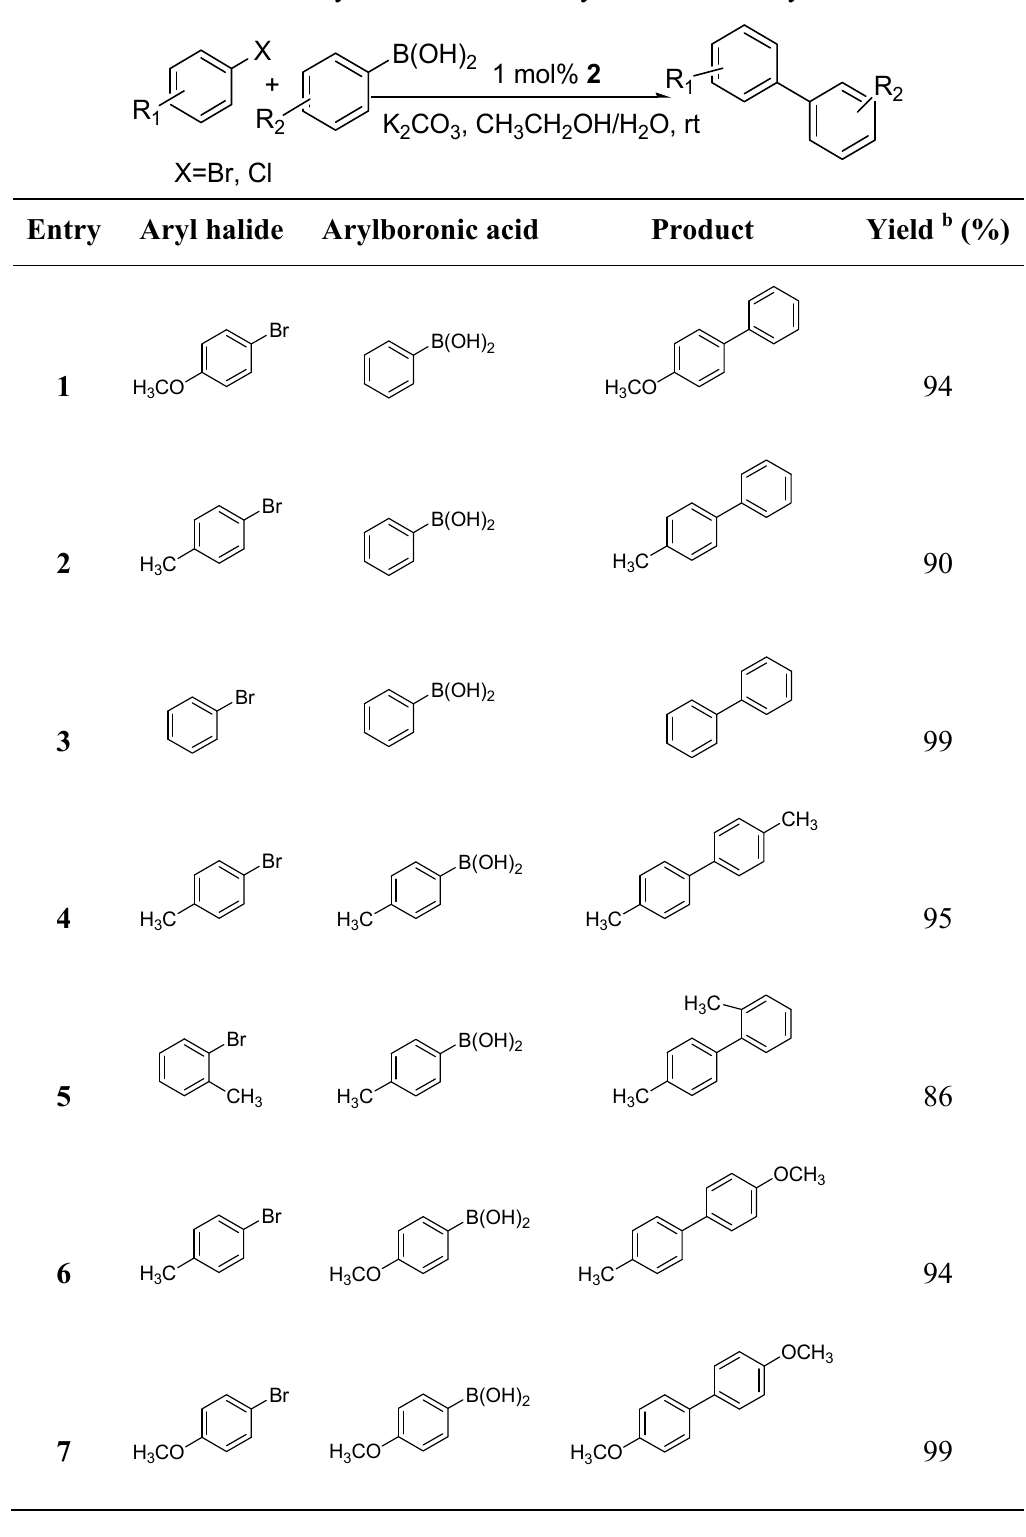
Table 2. The Suzuki-Miyaura reactions of aryl halides with arylboronic acids.